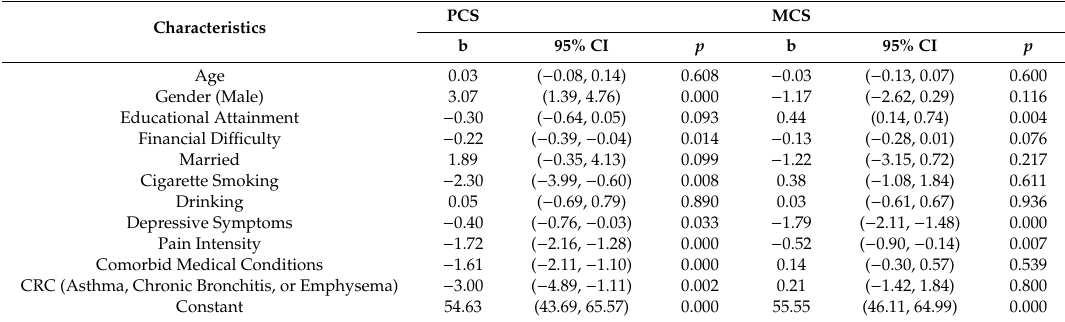
Table 3. Summary of two multivariable linear regression models with physical and mental HRQoL as outcomes.